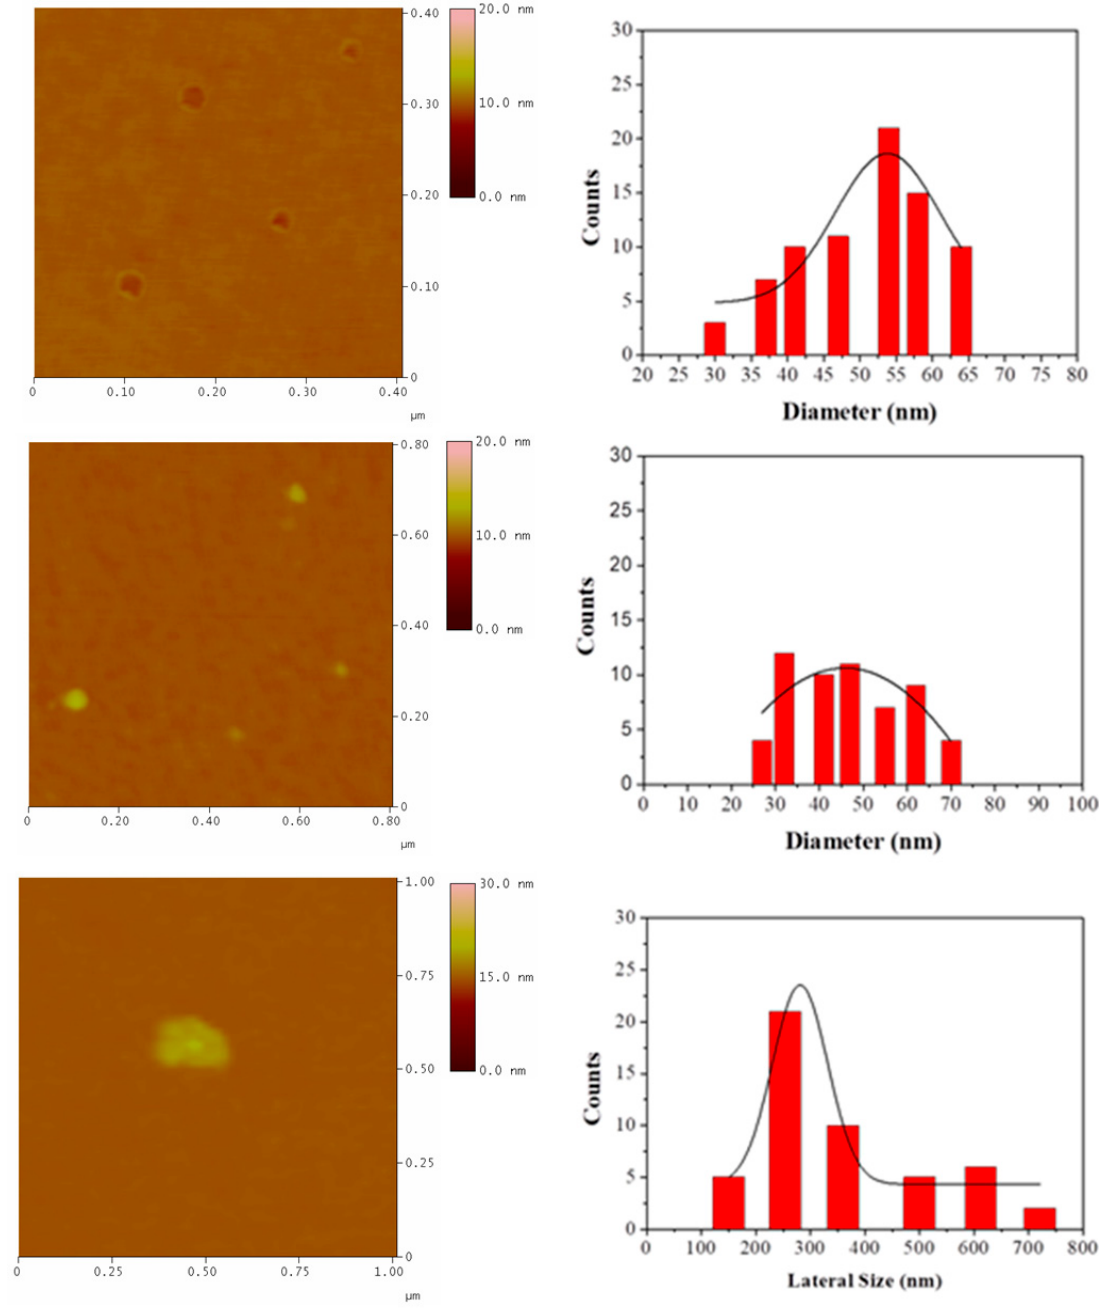
Figure 7. Atomic force microscopy (AFM) height images and statistical analysis of hollow spheres (top), dense carbon spheres (middle), and nanosheets (bottom).